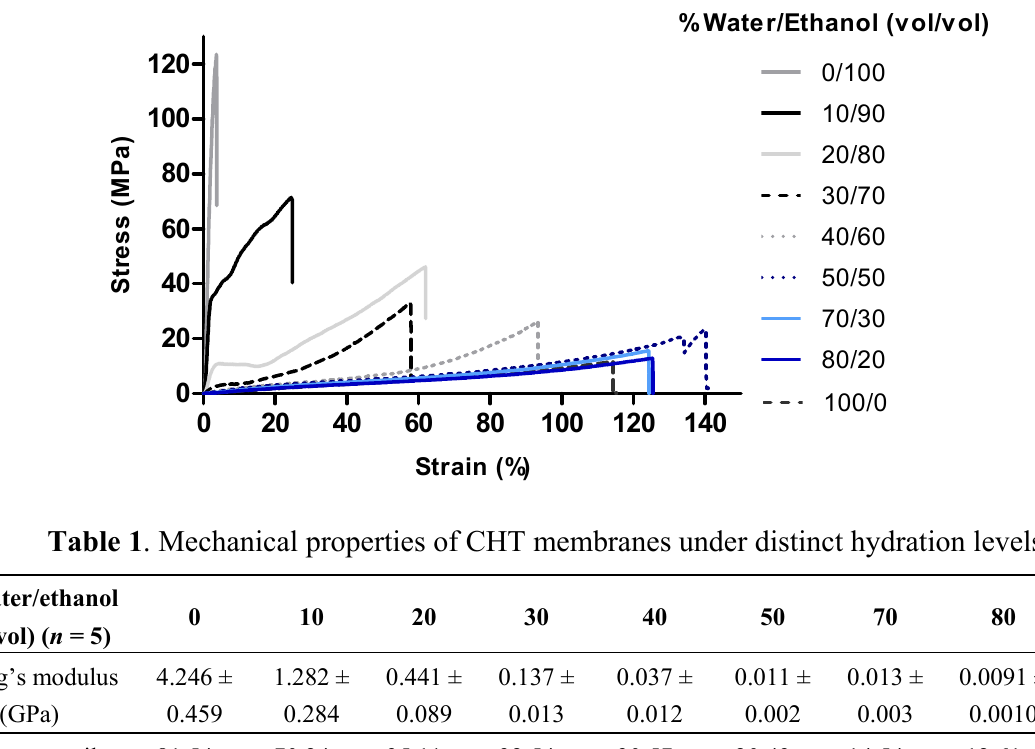
Figure 1. Representative stress-strain curves of chitosan (CHT) membranes at distinct hydration levels.